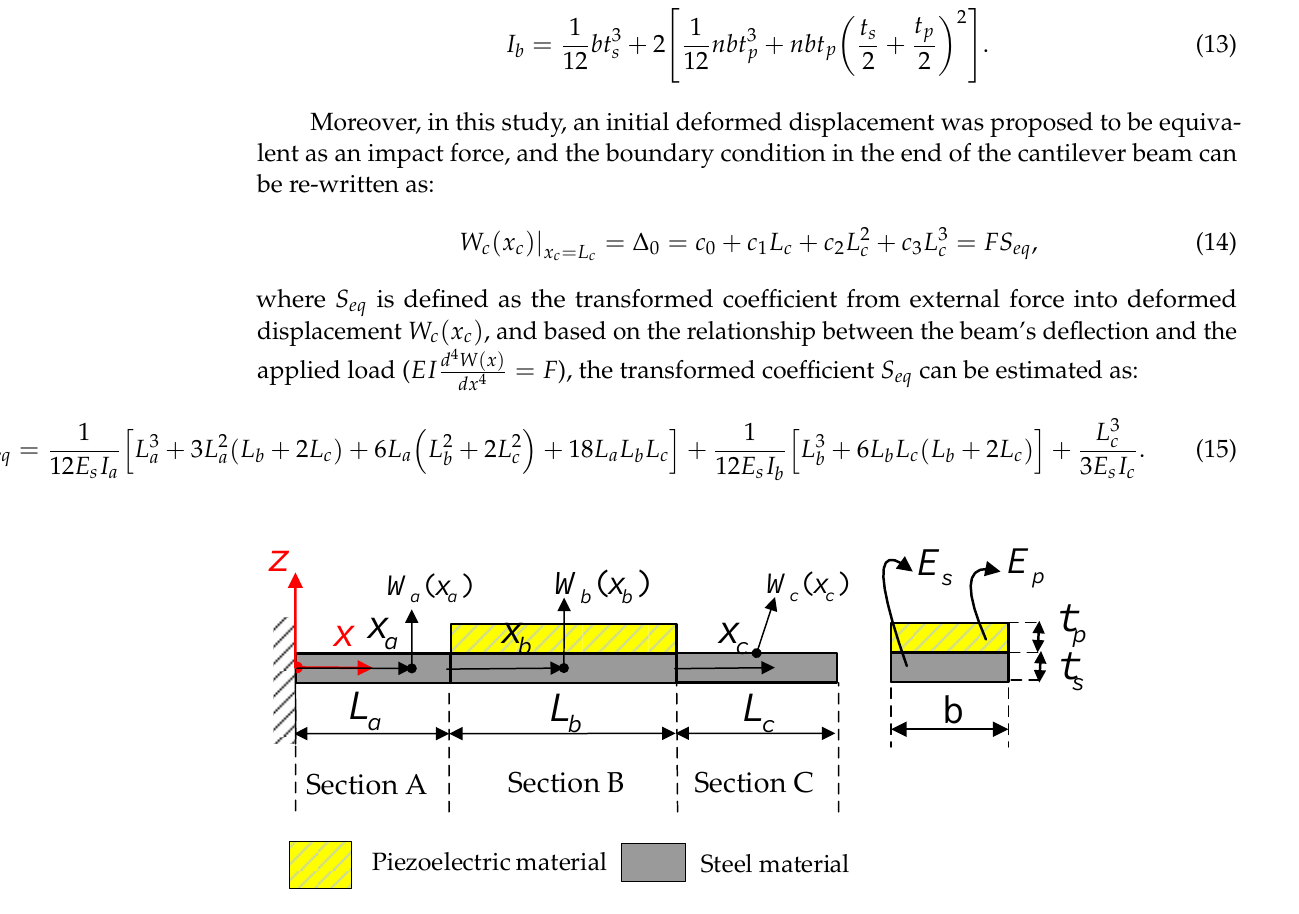
Figure 3. Theoretical model of piezoelectric cantilever beam structure, which is separated into three sections.